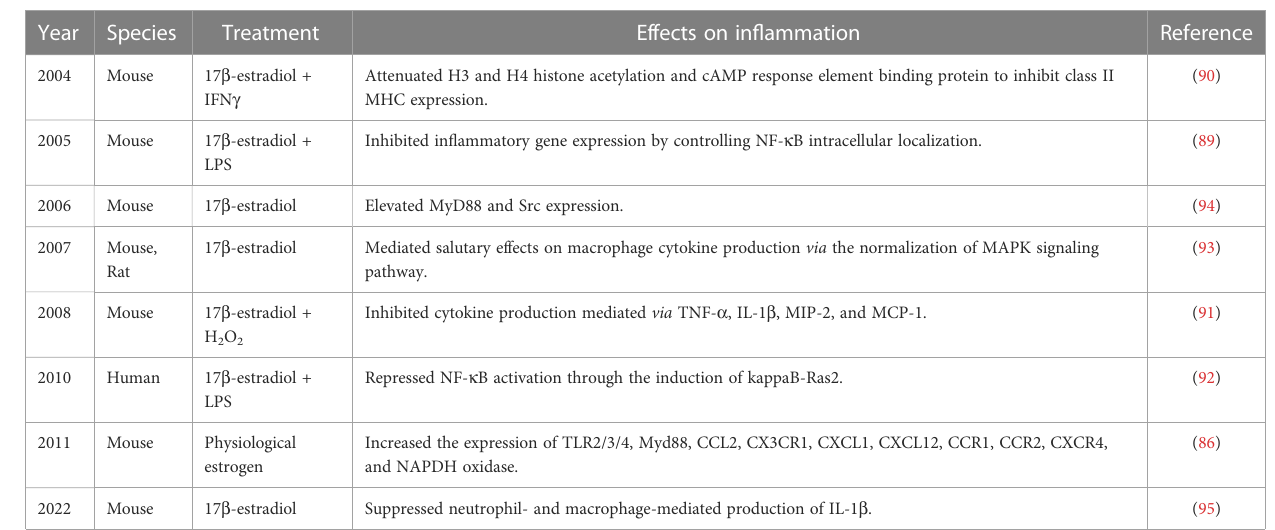
TABLE 3 Anti-in fl ammatory effects of estrogen on macrophages.